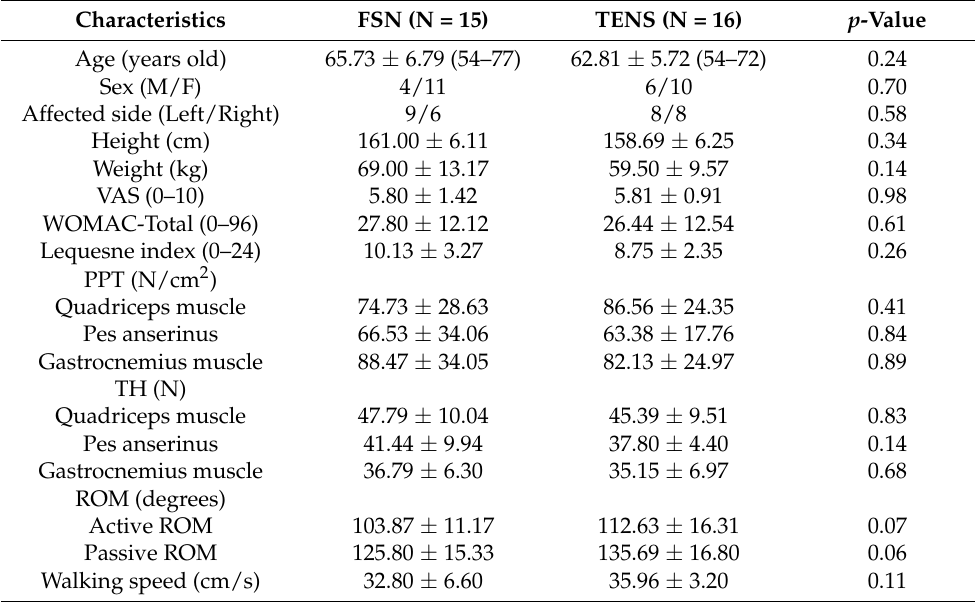
Figure 4. Flow chart summarizing follow-up on clinical outcomes and treatment preferences. Table 1. Baseline characteristics and clinical evaluation indicators of